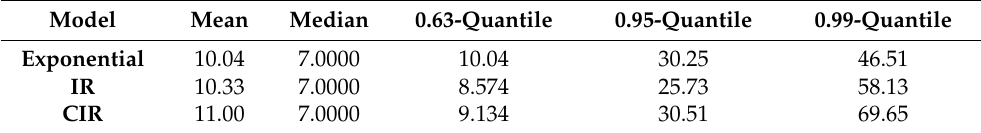
Table 1. Some statistical parameters of the three models for WS with same median = 7 m/s.